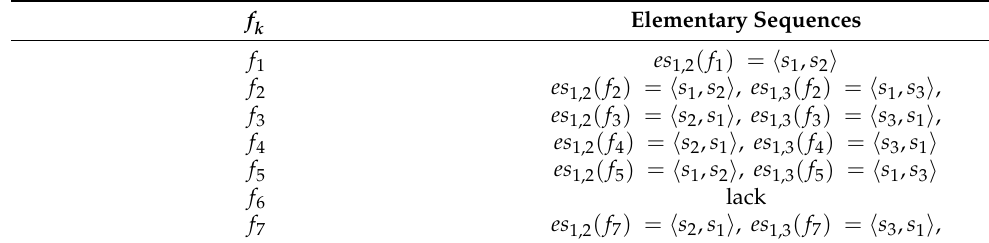
Table 5. Elementary sequences for the diagnosed process.